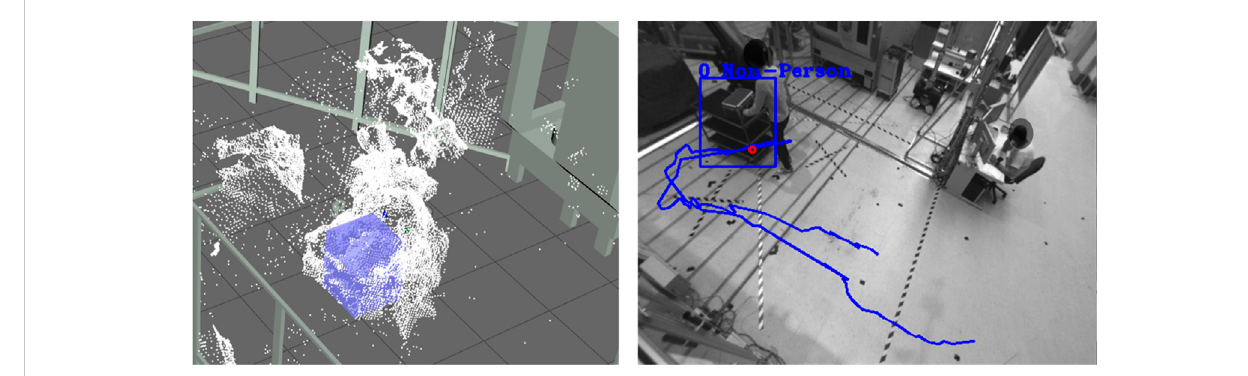
FIGURE 11 (Left) undetected Person in point cloud, (Right) unclassi fi ed Person in RGB Image.